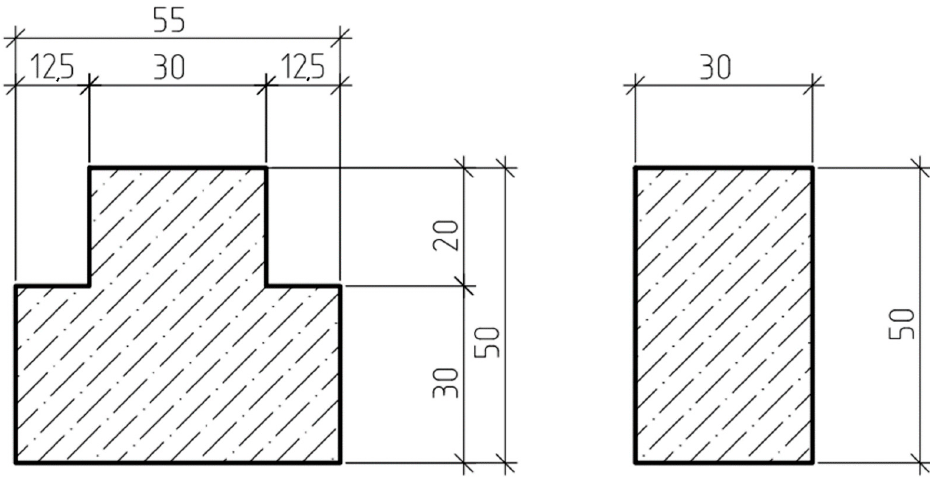
Figure 7. The studied cross sections of the bar elements. Dimensions are given in mm.